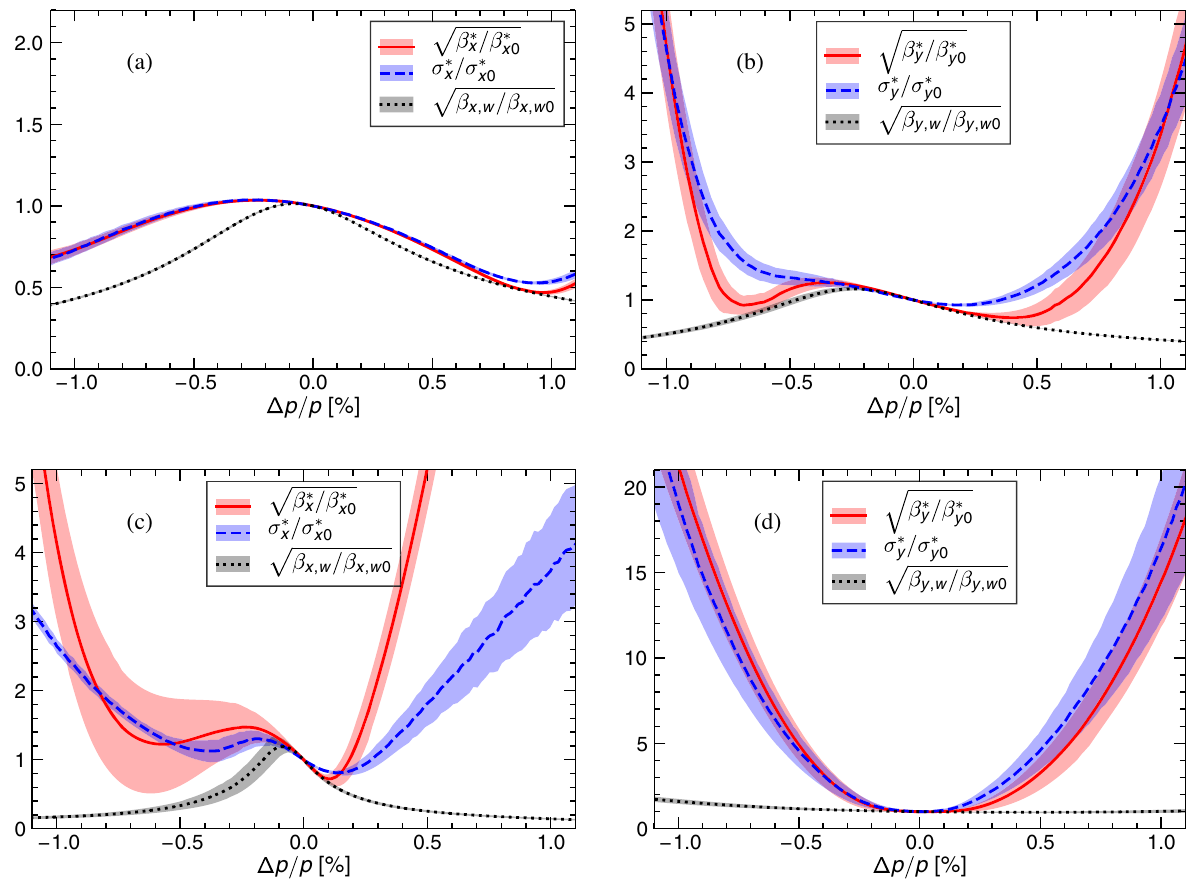
FIG. 3. Momentum bandwidths of the ATF2 10 β (cid:1) x 1 β (cid:1) y optics (a, b) and ultralow β (cid:1) optics (c, d). σ (cid:1) x and σ (cid:1) y are the IP horizontal and vertical beam sizes, respectively. β x;w and β y;w are the horizontal and vertical β functions at beam waist, respectively. The actual random momentum offset is roughly the momentum spread (0.08%) and the resulted beam-size growth is small comparing with other systematic